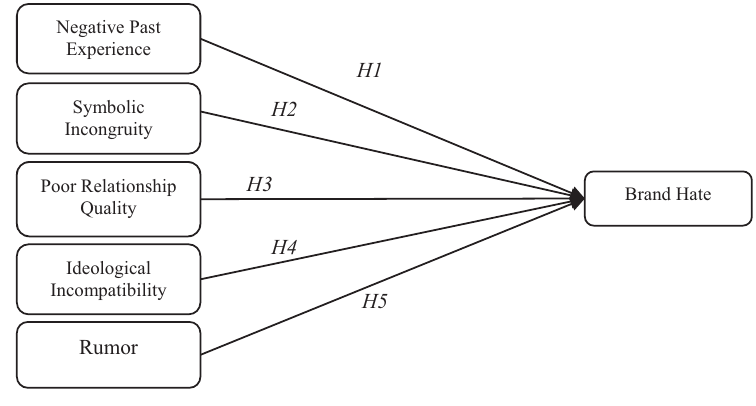
Figure 1. Theoretical